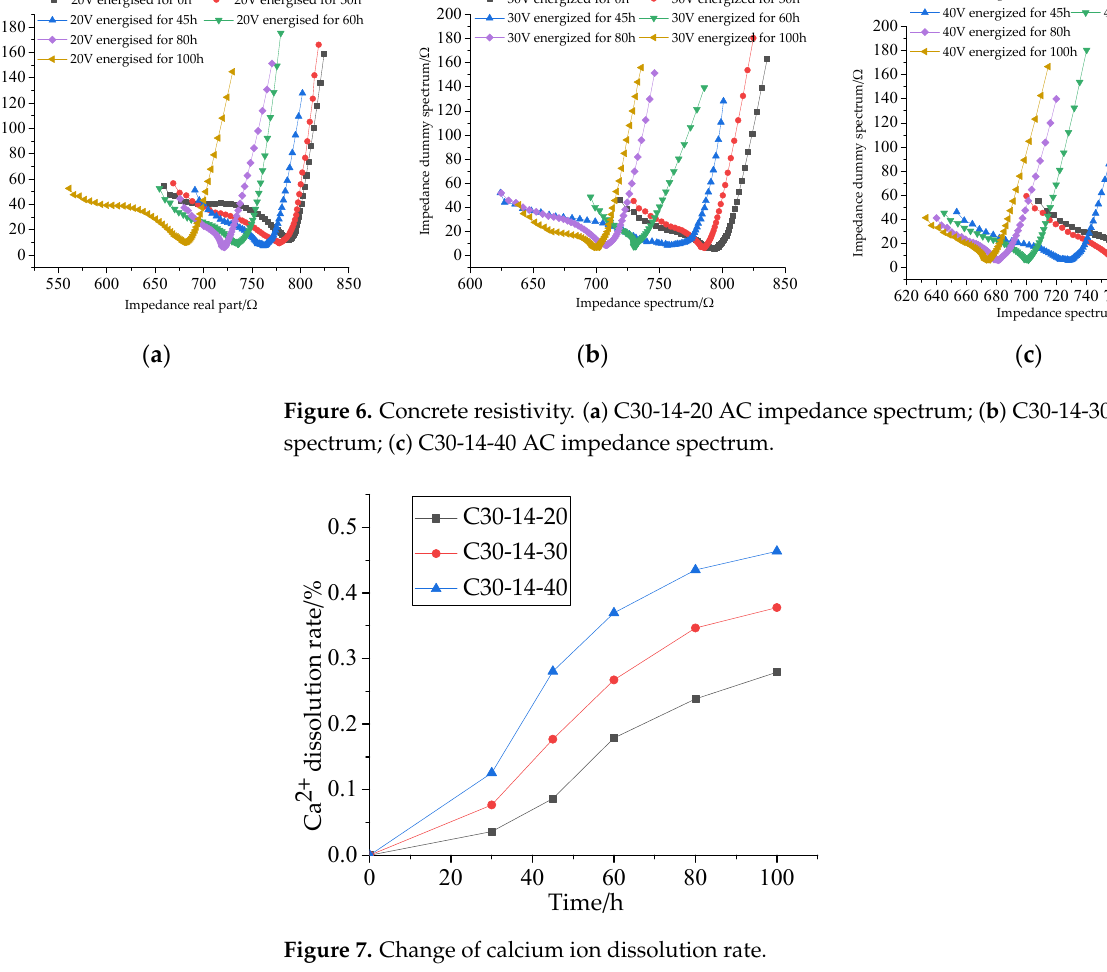
Table 3. Volume resistance loss rate of concrete under different voltages (%).